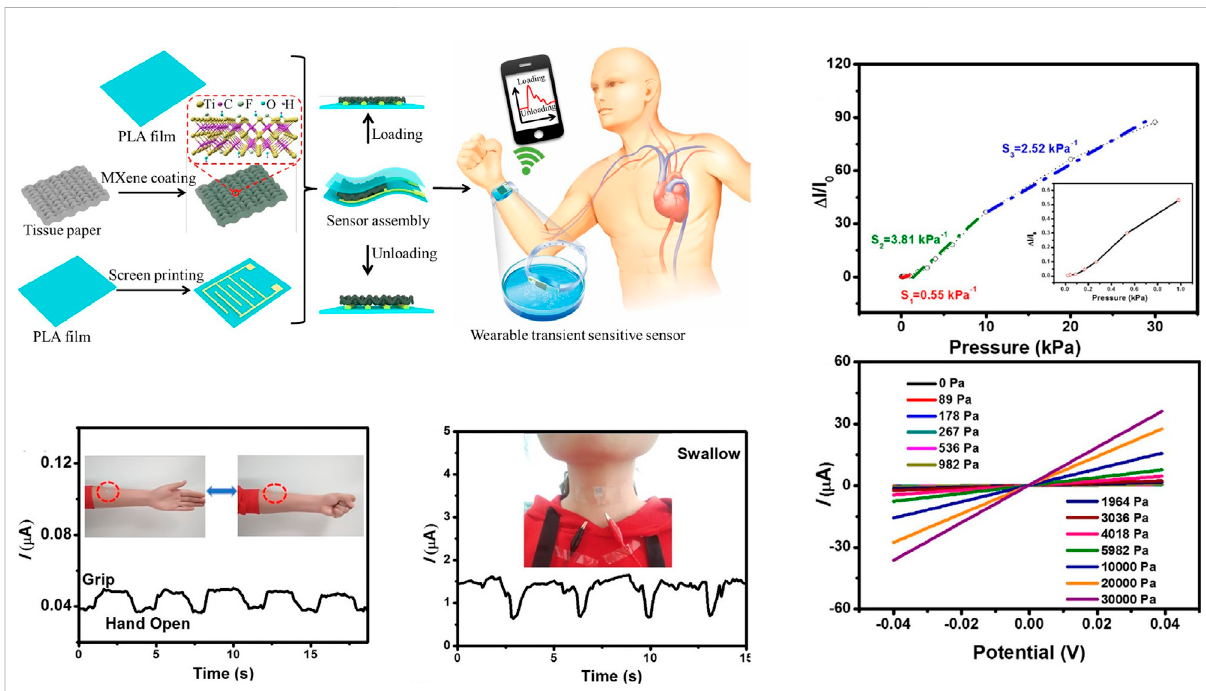
FIGURE 6 (A) Schematic illustration of the fabrication procedure of fl exible wearable transient pressure sensors with MXene nanosheets. (B) Sensing performanceofthepressuresensorattachedtothearmmuscleforreliabledetectionofradialmusclecontractionresultingfromreversiblymakinga fi st. Inset: Photograph of the sensor attached onto the arm muscle while reversibly making a fi st. (C) Sensing performance of the pressure sensor adhered onto a human throat for the timely sensing of swallowing. Inset: Photograph of the sensor attached onto a human throat. (D) Sensing sensitivity of the fl exible pressure sensor to pressure. (E) I − V curves of the sensor with various applied pressures, Reproduced with permission from Guo et al. (2019), ©American Chemical